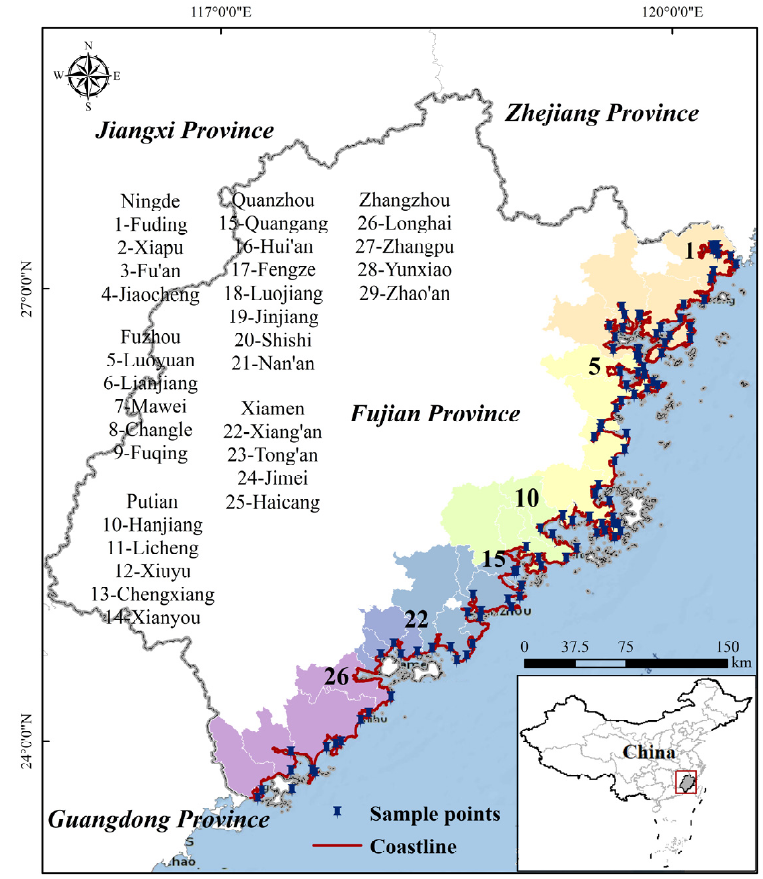
Figure 1. Geographical settings of Fujian Province.